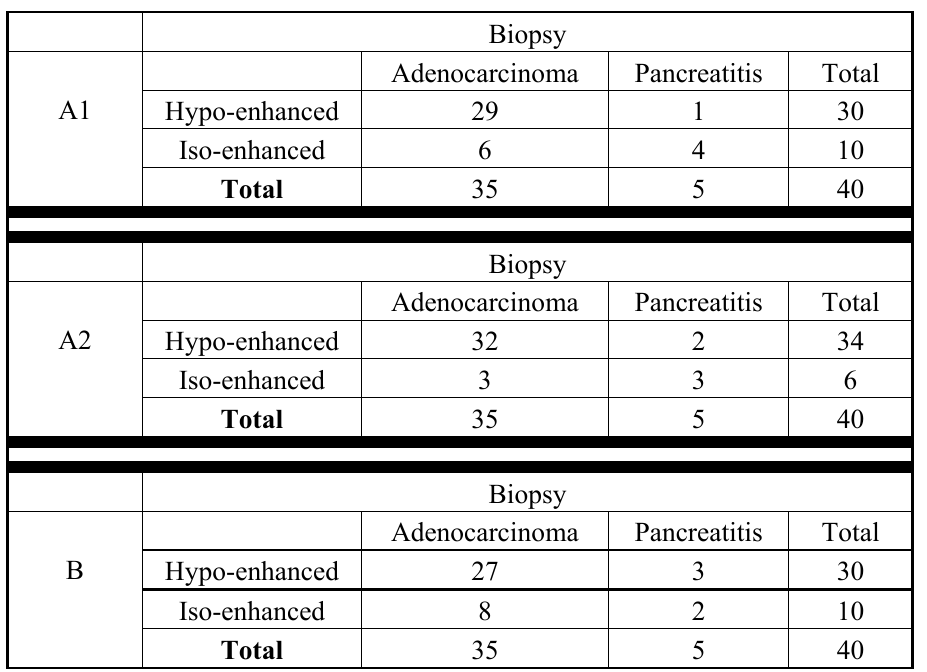
Table 4. Distribution of the observations concerning the visual interpretation of the contrast-enhancement compared to biopsy.